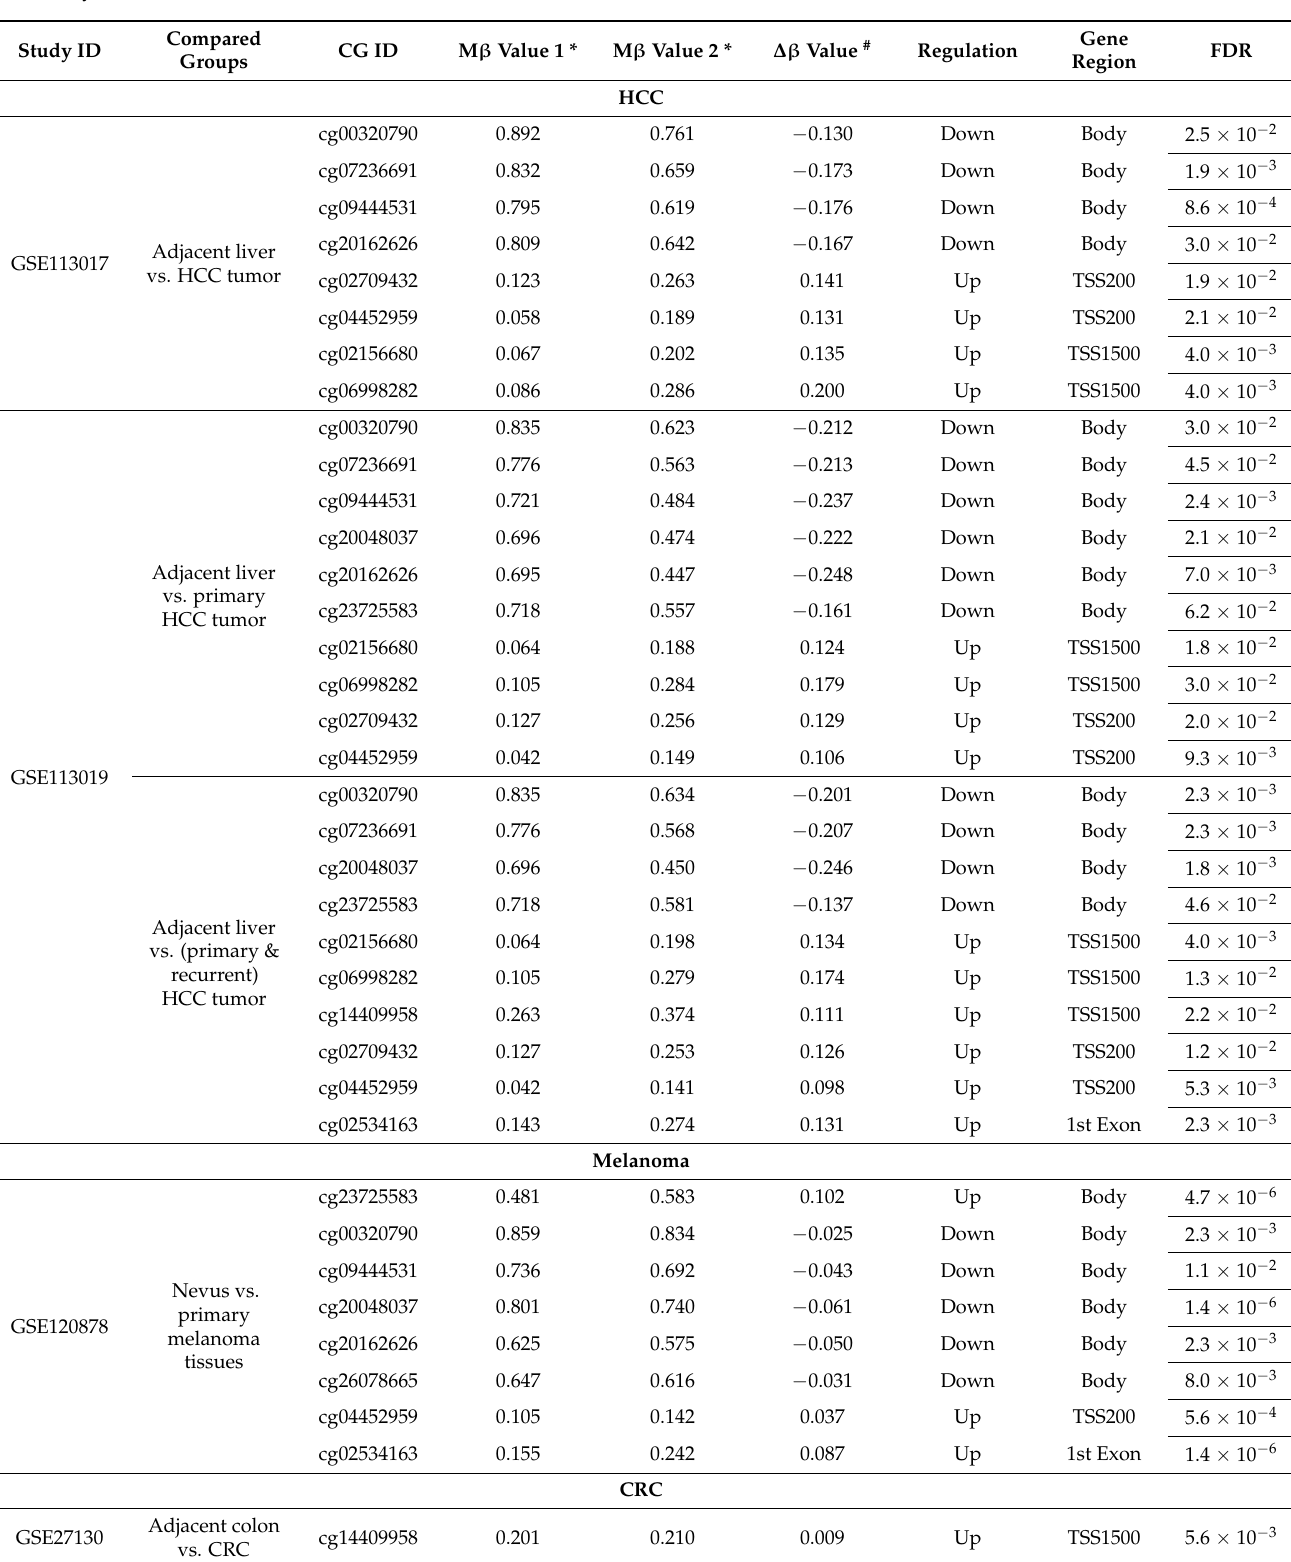
Table 2. DMCs presenting higher or lower methylation in cancer in relation to corresponding control, identified via in silico analysis in ENPP2